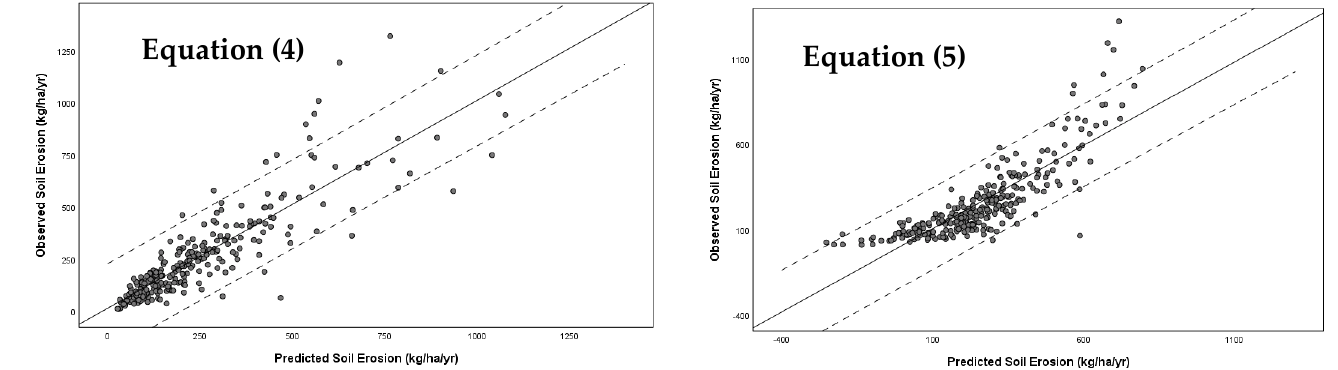
Figure 2. One-to-one relationship between predicted and observed values. Figure 2. One ‐ to ‐ one relationship between predicted and observed values.